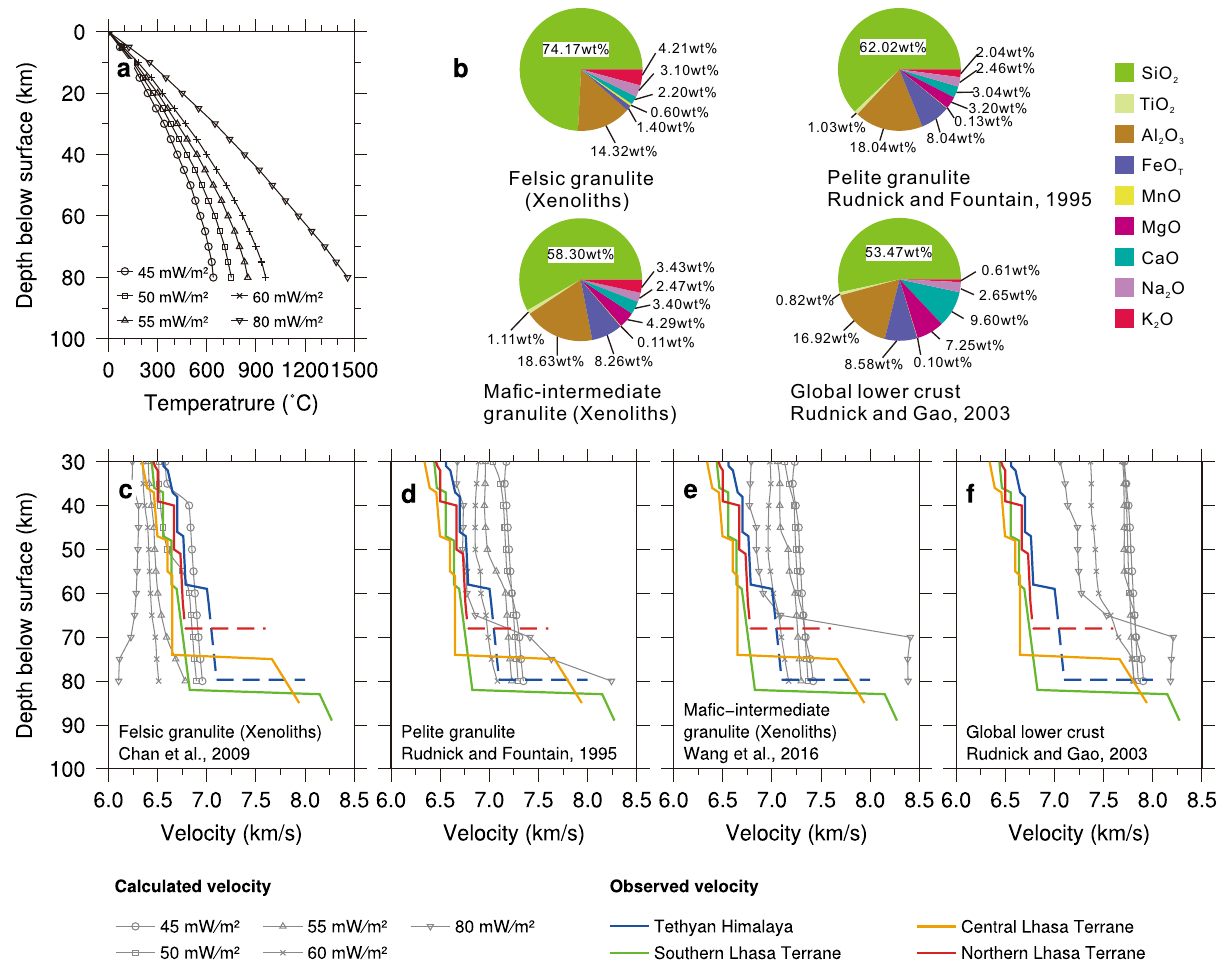
Fig. 4 Observed vertical velocity pro fi les compared with calculated velocities for major relevant rock types at different temperature. Calculations were carried out with the Perple_X_6.8.5 phase equilibrium modeling program 36 for the internally consistent thermodynamic dataset ds62 37 . The composition of rocks is chosen according to xenoliths (felsic granulite and ma fi c-intermediate granulite) in southern Tibet 39,40 as well as a pelite granulite 1 and a global average lower crustal model 41 . a Calculated geotherms for different assumed heat fl ow values. b Composition of the four chosen rock types. c – f Observed vertical velocity pro fi les in the four characteristic tectonic parts along the pro fi le, superimposed by calculated velocity pro fi les for the four selected